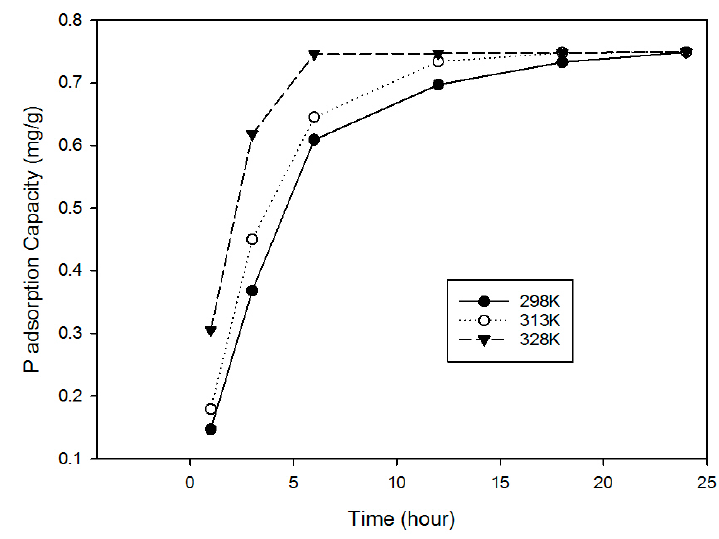
Figure 6. P sorption by concrete studies at various temperatures; Dose of media 2 g; initial P concentration 15 mg/L; contact time 24 h; agitator 180-rpm; pH 5. Int. J. Environ. Res. Public Health 2018 , 15 , 357 10 of 16